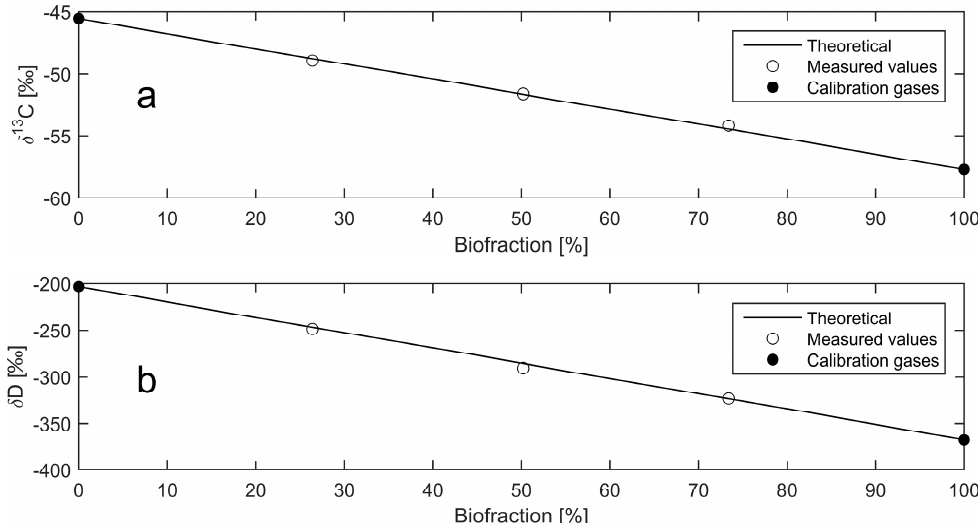
Figure 5. Biofraction determination with the developed laser spectrometer. The average of 100 consecutive measurements of δ 13 C ( a ), and 10 consecutive measurements of δ D ( b ), in CH 4 . Table 1. Results of isotopic analysis of three biogenic methane samples and one fossil. Sample Bio 1 * Bio 2 Bio 3 Fossil